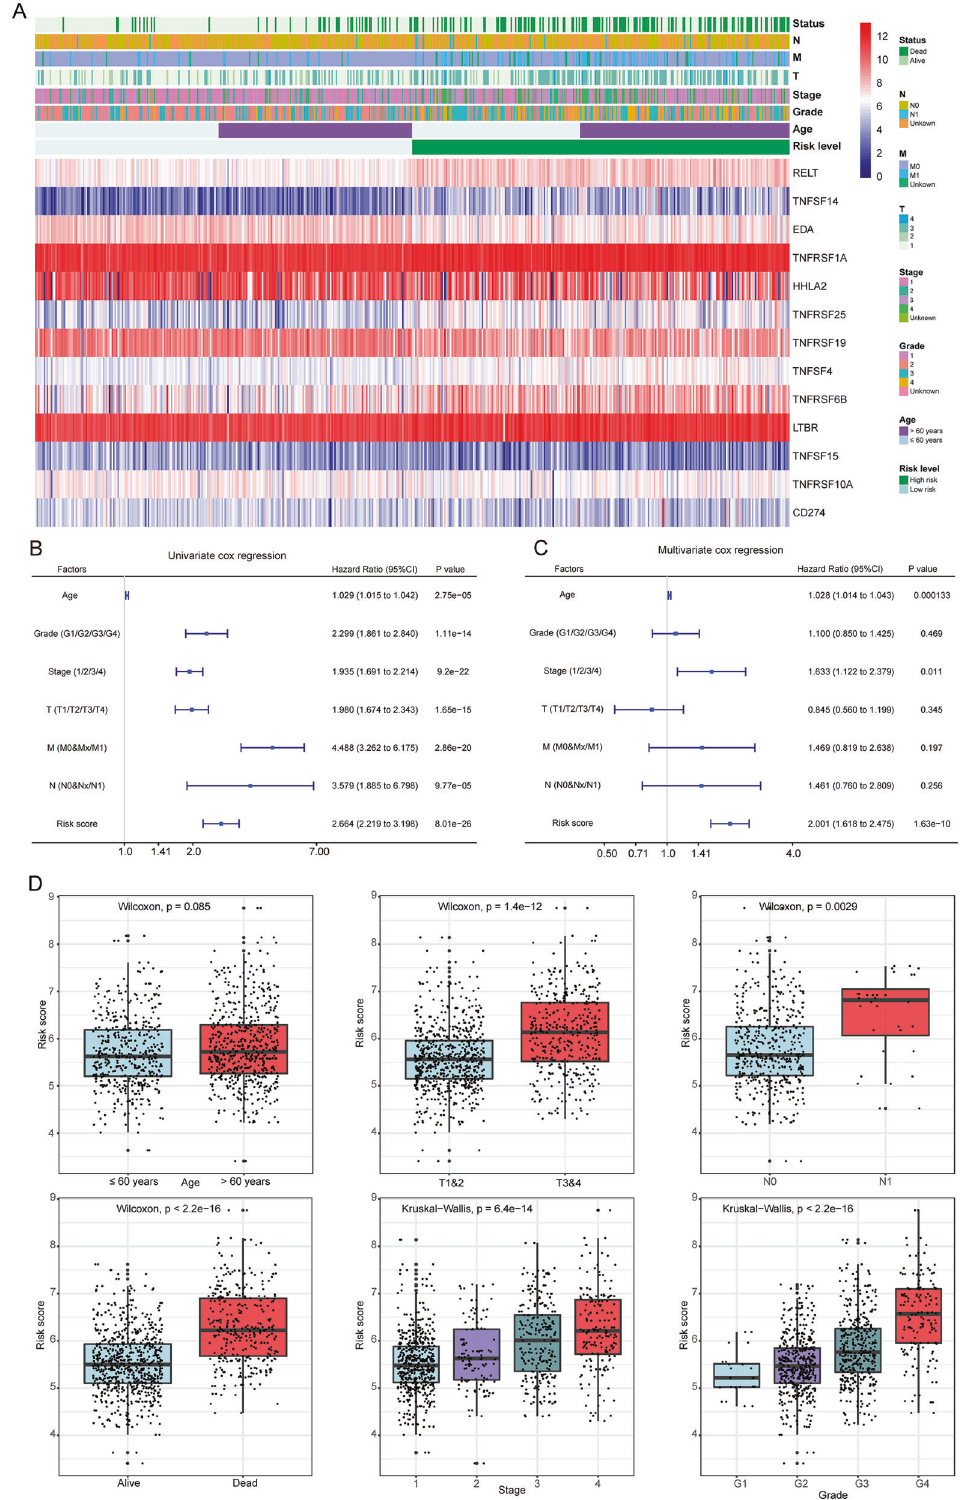
Fig. 6 Relationship between the prognostic signature and clinicopathological factors of ccRCC patients. A The heat map shows the expressions of the 13 costimulatory molecule genes and clinicopathological factors in the high- and low-risk groups. The univariate ( B ) and multivariate ( C ) Cox regression analyses of prognosis for the prognostic signature and clinicopathological factors. The bar chat showed that the risk score of the prognostic signature in different clinical subgroups. ns: P > 0.05, * P < 0.05, ** P < 0.01, *** P < 0.001, **** P <